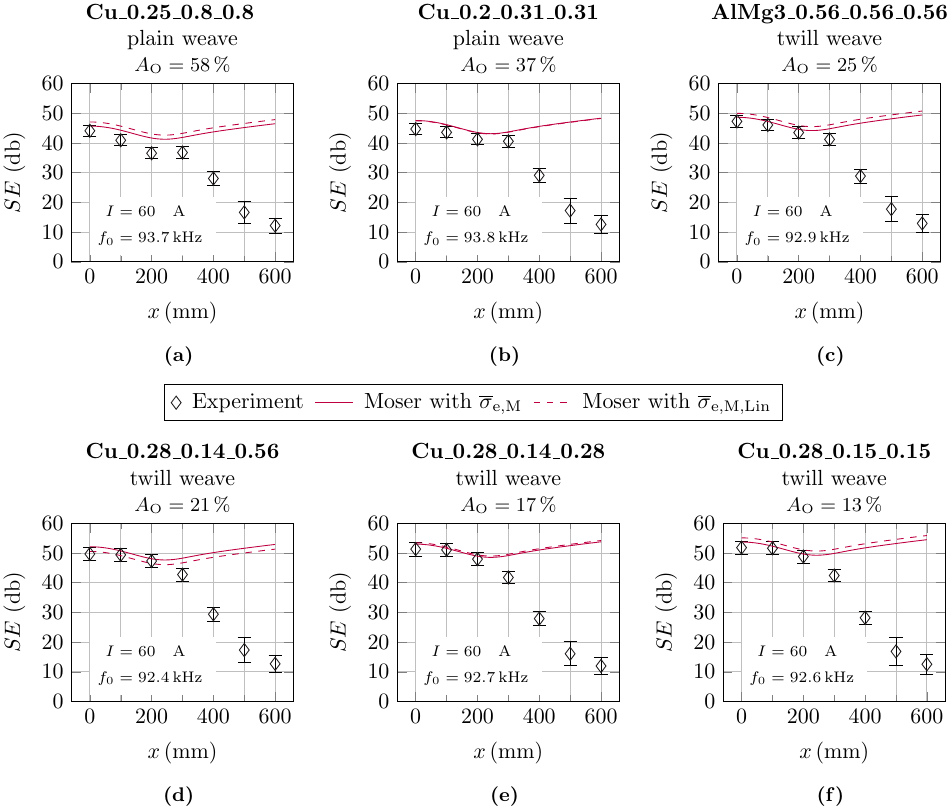
Figure 10. Comparison of the measured and analytically calculated shielding effectiveness SE based on the mean specific electrical conductivity σ e,M determined by the experiment and σ e,M,Lin calculated by the proposed linear approximation: ( a ) Cu_0.25_0.8_0.8, ( b ) Cu_0.2_0.31_0.31, ( c ) AlMg3_0.56_0.56_0.56, ( d ) Cu_0.28_0.14_0.56, ( e ) Cu_0.28_0.14_0.28 and ( f )